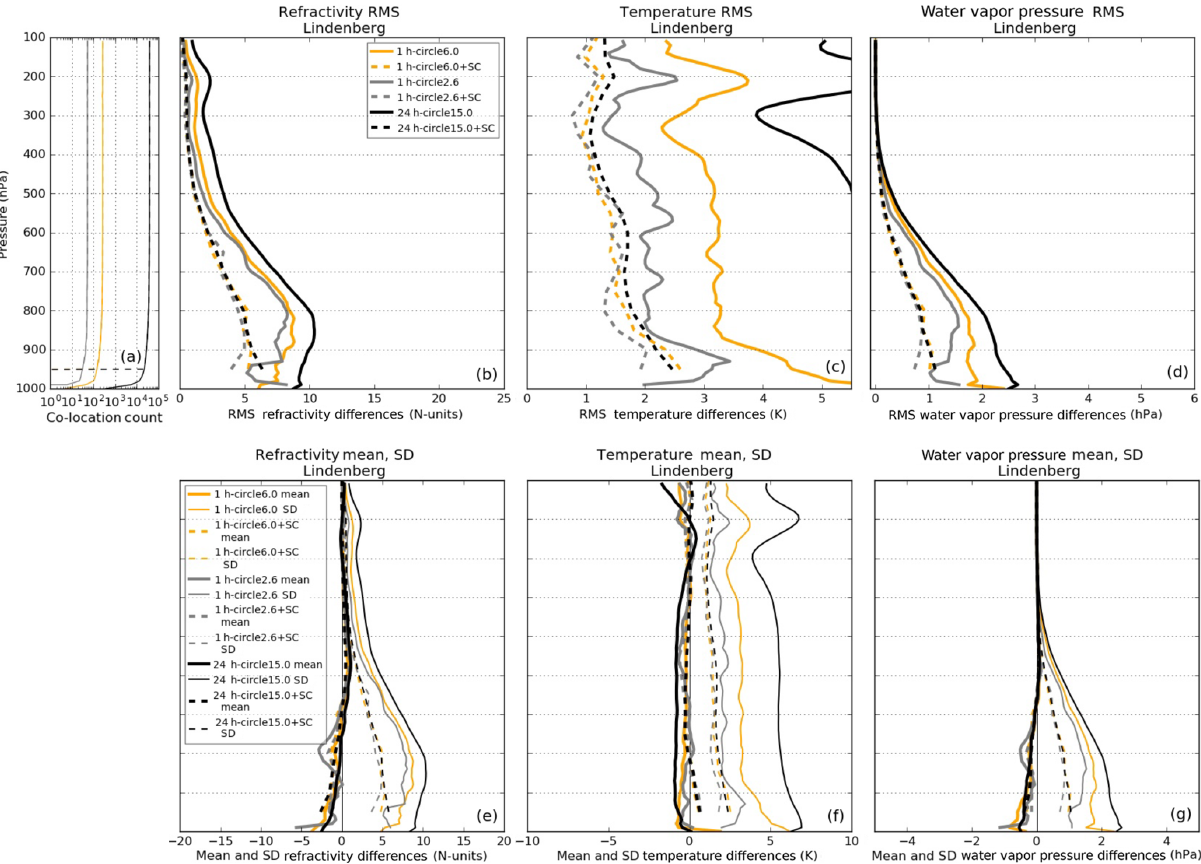
Figure A4. RMS (b–d) , mean (thick; e–g ), and SD (thin; e–g ) RO–RS profiles for refractivity (b, e) , temperature (c, f) , and water vapor pressure (d, g) under three different co-location restraints with (dashed) and without (solid) the sampling correction (SC) applied: circles of radius 6 ◦ latitude (orange) and 2.6 ◦ latitude (grey) for time windows of 1h, and a circle of radius 15 ◦ latitude for a 24h time window (black). Comparisons are conducted at Lindenberg for January–March 2014. The number of co-located pairs for each co-location restraint (with SC: dashed; without SC: solid) are given in panel (a) , where the x axis is a logarithm